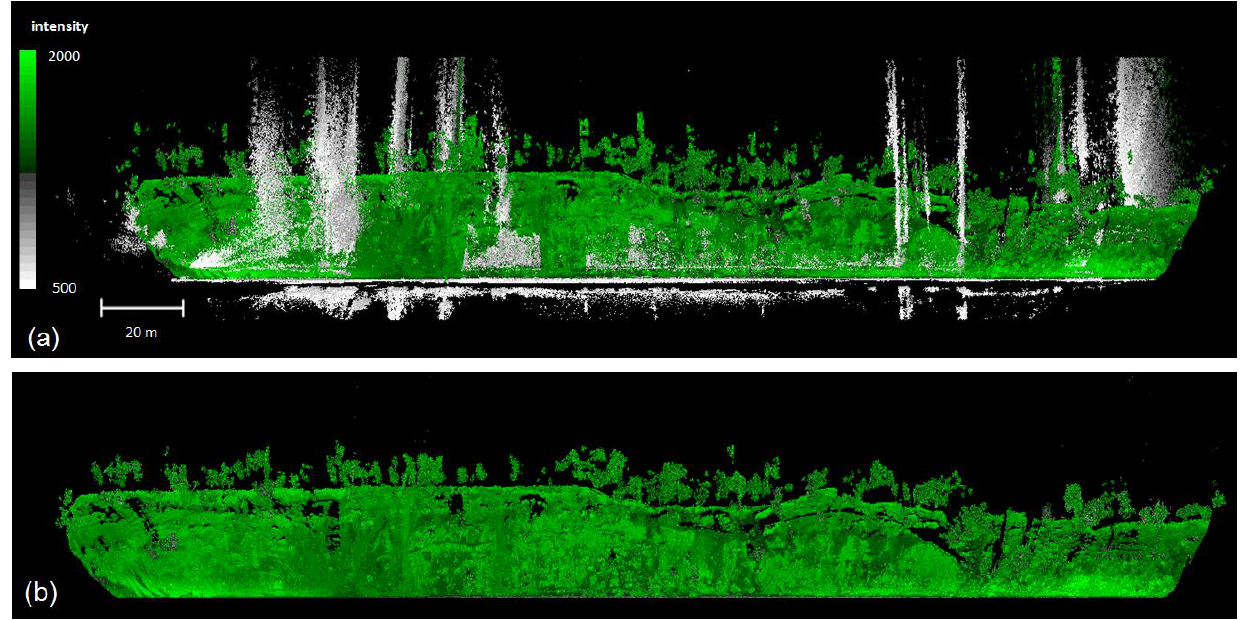
Figure 3. The intensity coloured point cloud and the front view of the river bank. ( a ) Data with noise points. ( b ) Data after noise point filtering and removal of the points below water